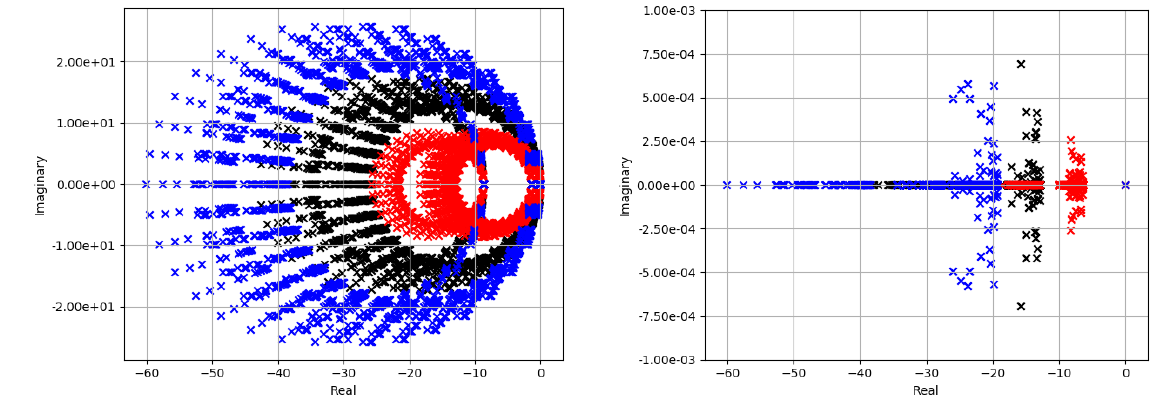
Figure 3: Spectrum at Various Flow Rates for Periodic Boundary Conditions.